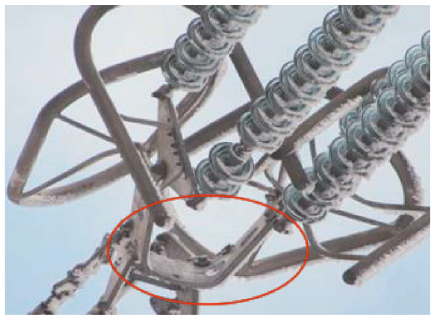
Figure 2: Yoke plate